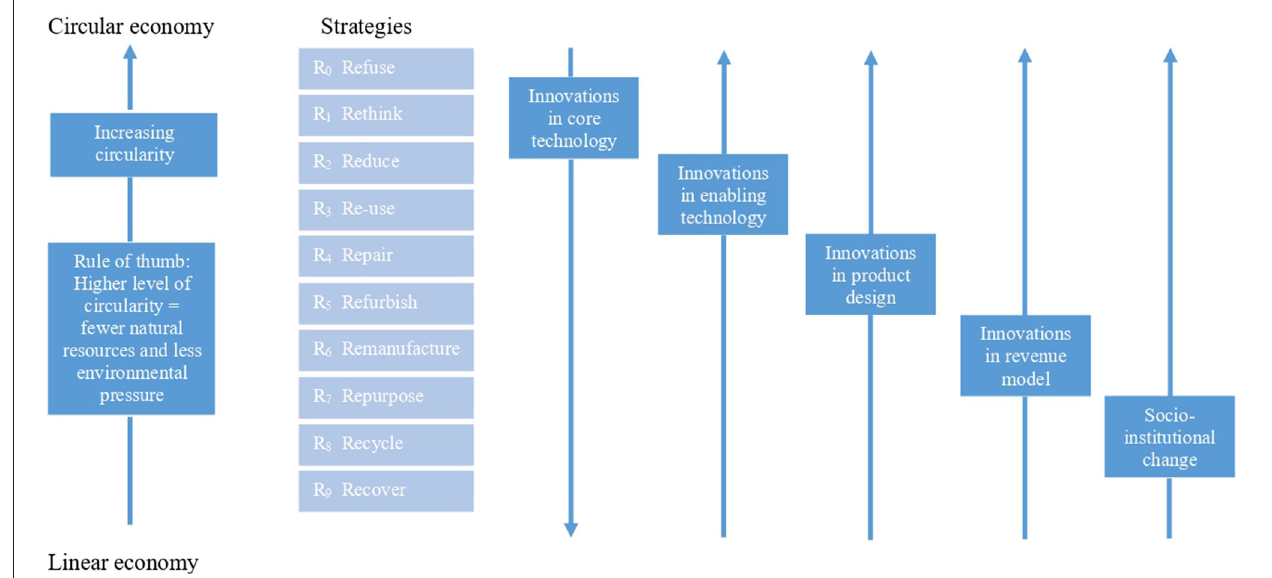
FIGURE 1 | Role of innovation in circular economy for production chains. Source: RLI 2015; edited by PBL Netherlands Environmental Assessment Agency, https:// www.pbl.nl/en/publications/circular-economy-measuring-innovation-in-product-chains.